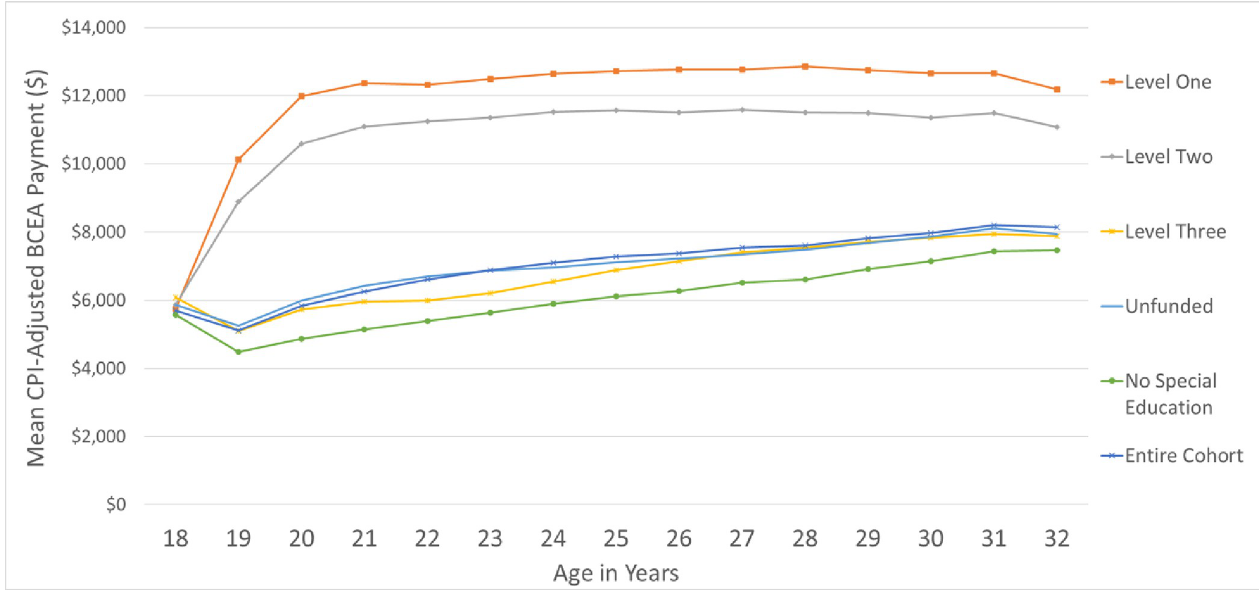
Fig 3. BCEA payments among those using special education. Mean inflation-adjusted British Columbia Employment and Assistance (BCEA) dollars Received over time, adjusted to British Columbia Consumer Price Index (CPI) per individual according to family equivalency scale.